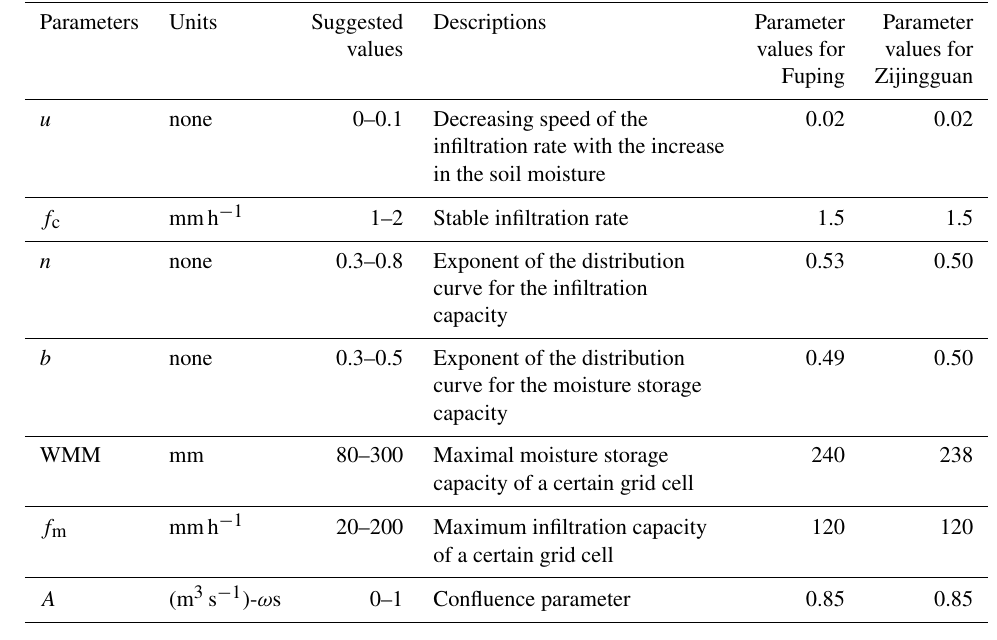
Table 6. Calibrated parameters in the Hebei model.